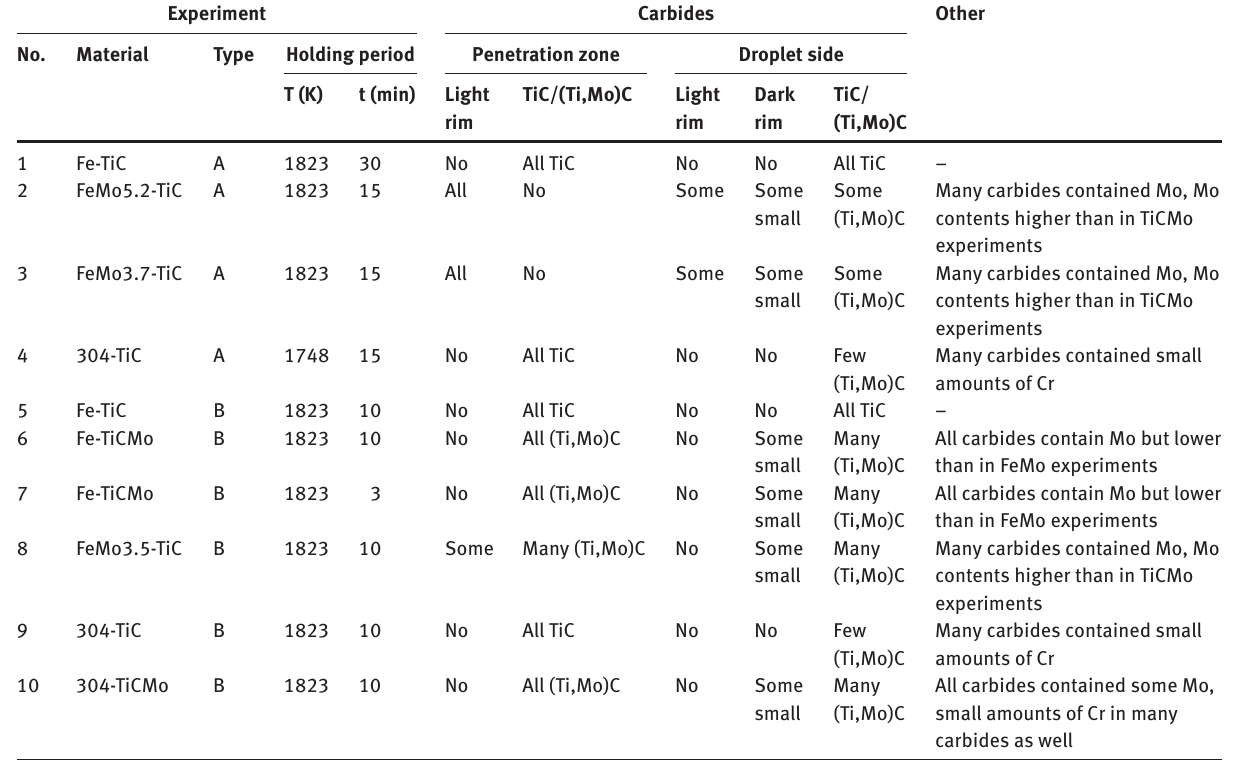
Table 7: Summary of the different carbides found in the experiments Experiment Carbides Other No. Material